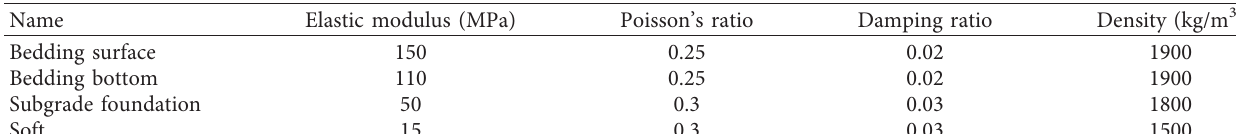
Figure 12: Numerical model. Table 3: Subgrade and soil parameters [30].